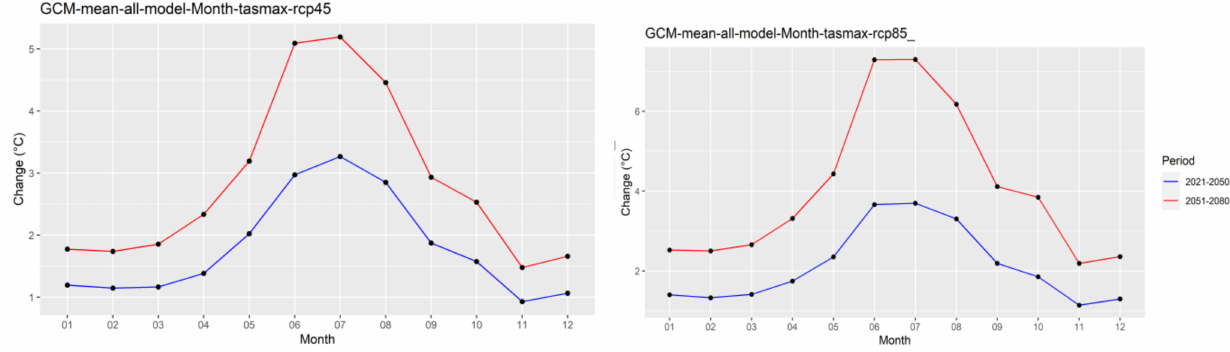
Figure 27. Average monthly temperature change (maximum) under RCP4.5 and RCP8.5 scenarios for the Devil’s Creek, 2021–2050 and 2051–2080 periods. The multi-model ensemble average of 15